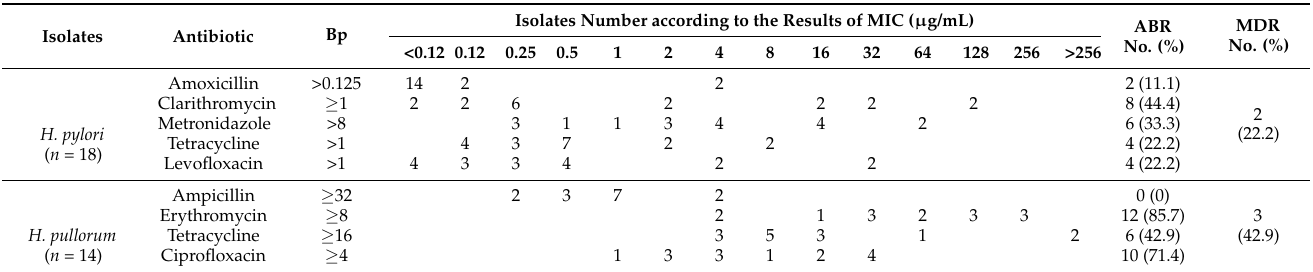
Table 5. Antimicrobial resistance profiles of H . pylori and H . pullorum isolates from chicken meat and environmental